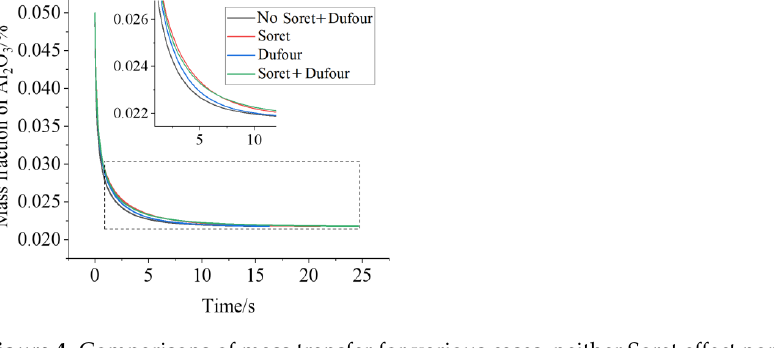
Neither the Soret nor the Dufour effect